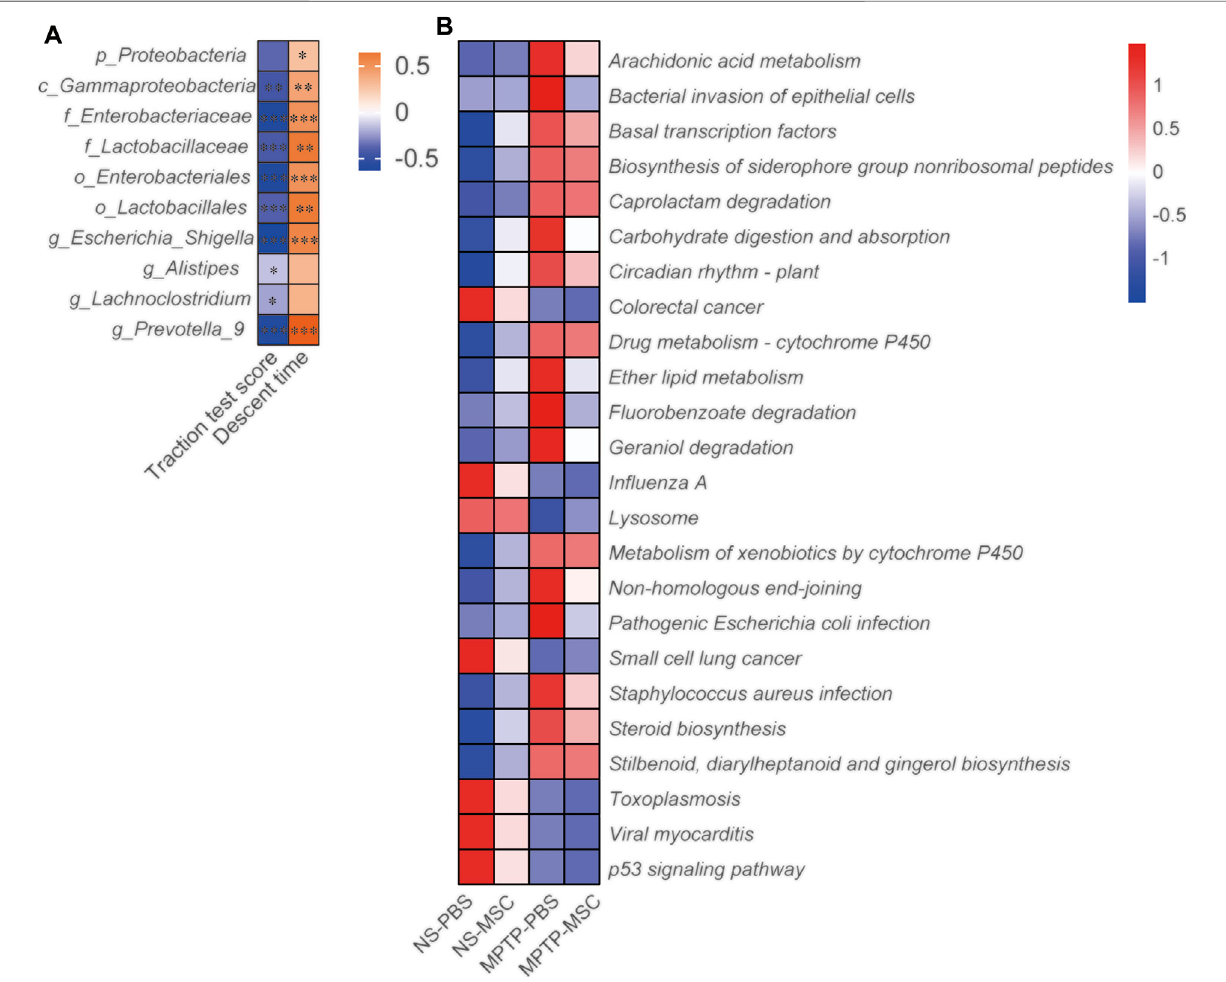
Frontiers in Cell and Developmental Biology |